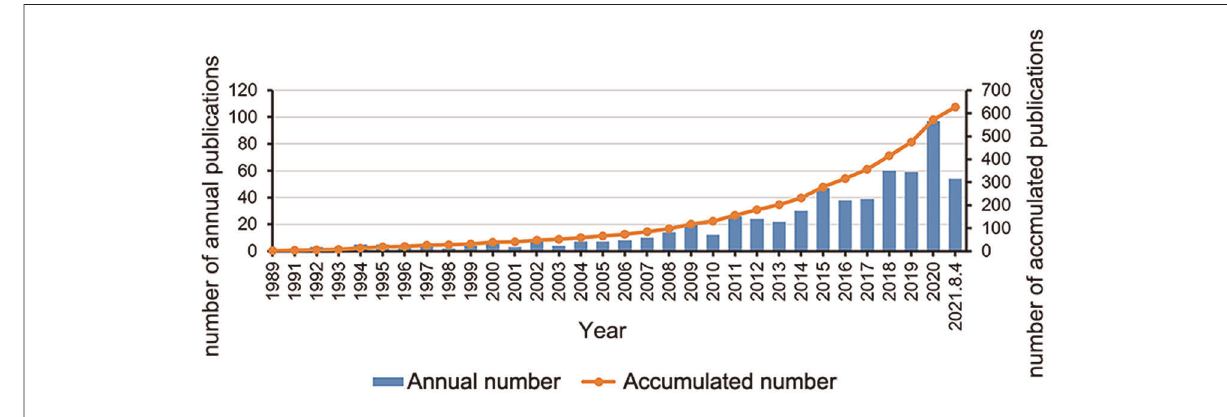
FIGURE 1 The annual number and accumulated number of publications on meniscal root tears research from 1989 to